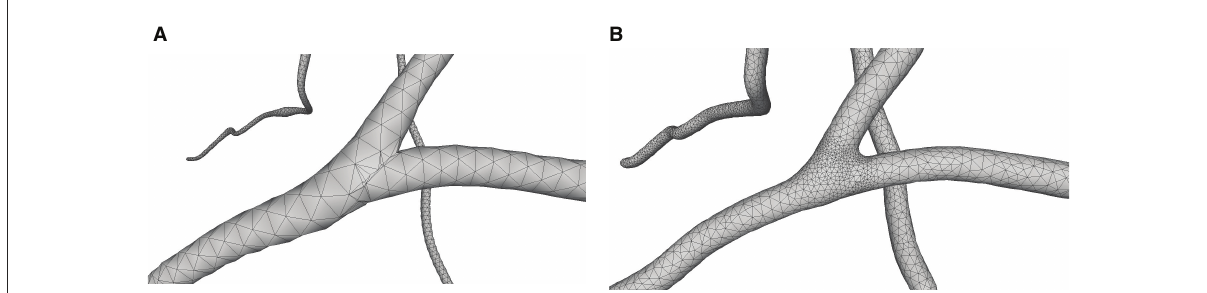
FIGURE1 (A) Non-adaptive mesh generation with ill-shaped triangles by traditional approaches. (B) High quality mesh generation with adaptive vertex densities by the proposed approach.